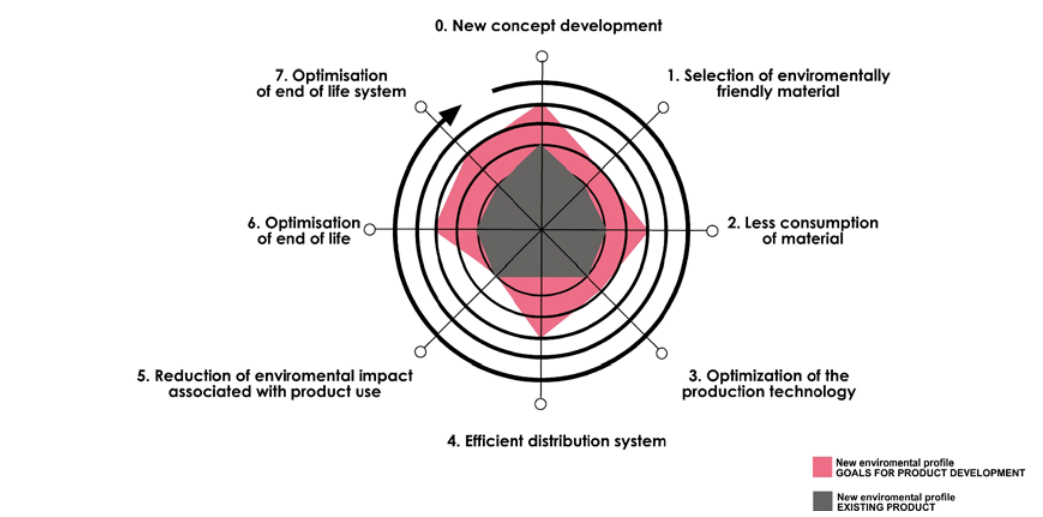
Figure 5. “A product’s environmental